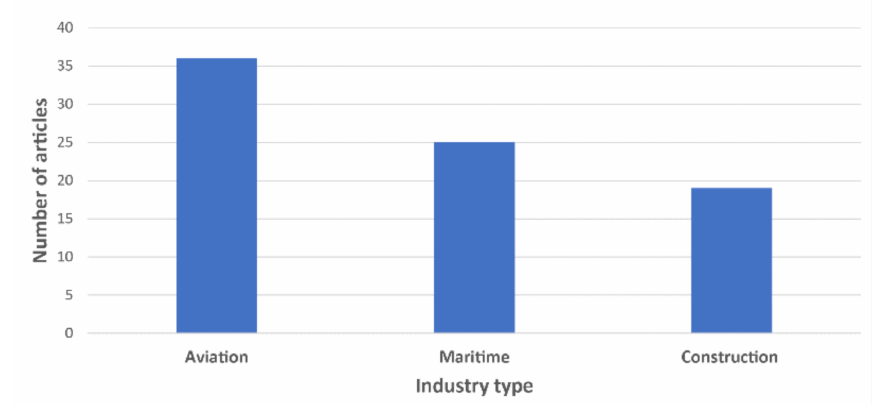
Figure 2. The distribution of eye tracking research articles by industry type.